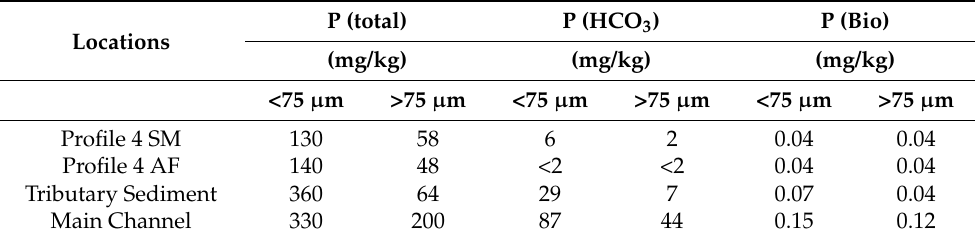
Table 3. Phosphorus data for Takalarup Creek